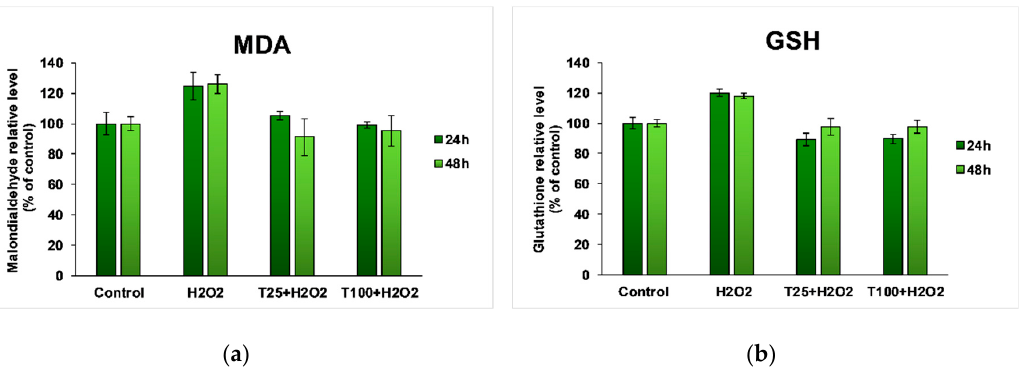
Figure 3. Malondialdehyde (MDA) ( a ) and reduced glutathione (GSH) ( b ) levels in Caco-2 cells exposed to di ff erent concentrations of Thuja occidentalis MT for 24 and 48 h in the presence of H 2 O 2 . Results are expressed as the mean ± standard deviation (SD) ( n = 3) and represented relative to the untreated cells (control).